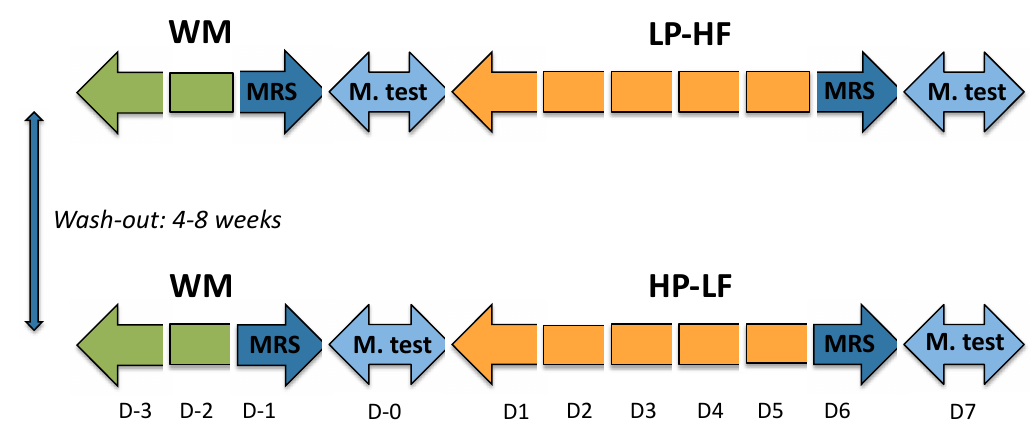
Figure 1. Experimental protocol. Each participant took part in two overfeeding periods according to a randomized, cross-over design. WM: weight maintenance diet, LP-HF: hypercaloric (150% energy requirement high-sucrose, low protein-high fat); HP-LF: hypercaloric (150% energy requirement high-sucrose, high protein-low fat); MRS: magnetic resonance spectroscopy for measurement of IHCL and IMCL; M. test: metabolic test, consisting of measurements of energy expenditure, plasma hormones, and substrate concentrations after ingestion of WM meal providing 40% of total energy requirements (D0), or LP-HF/HP-LF meals providing 60% of total energy requirements.